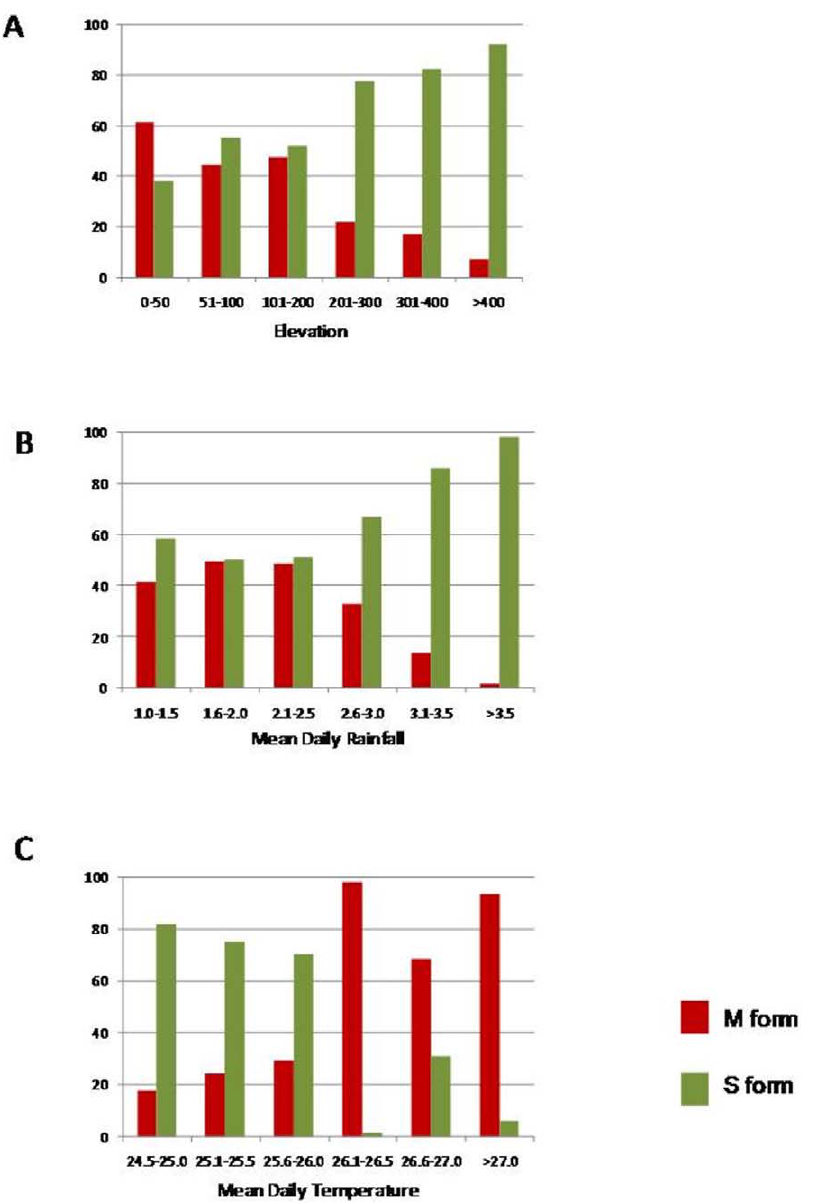
Figure 4. Mean prevalence of An.gambiae M and S forms plotted against elevation, precipitation, and temperature groupings.